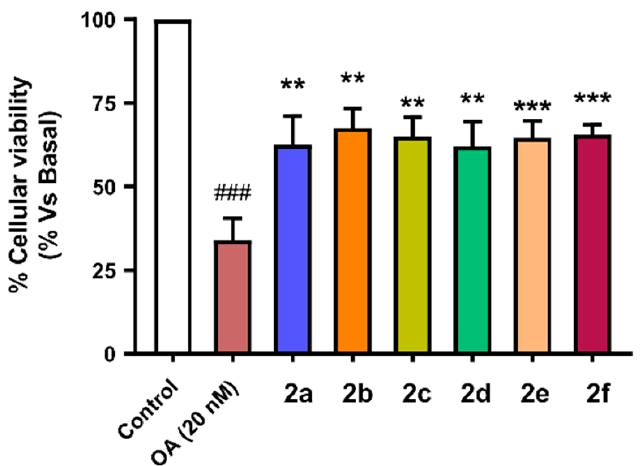
Figure 8. Neuroprotective capacity of compounds 2a – f against Tau hyperphosphorylation induced by treatment with okadaic acid (OA, 20 nM). SH-SY5Y neuroblastoma cells were treated with the cor-responding compound (1 µ M) during 24 h, and then cells were co-incubated with the corresponding compound and the OA (20 nM) combination for a further 24 h. Finally, cellular viability was assayed by the MTT method. Data are the means of six different cultures in duplicate. One way ANOVA Newman Keuls post-hoc test: ### p < 0.001 compared to basal; ** p < 0.01, *** p < 0.001 compared to